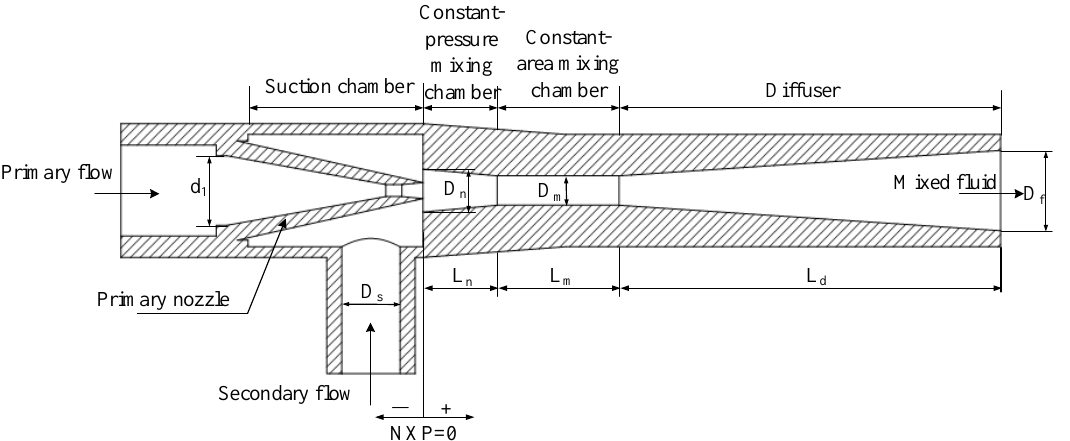
Figure 2. Structure of the two-phase flow ejector.